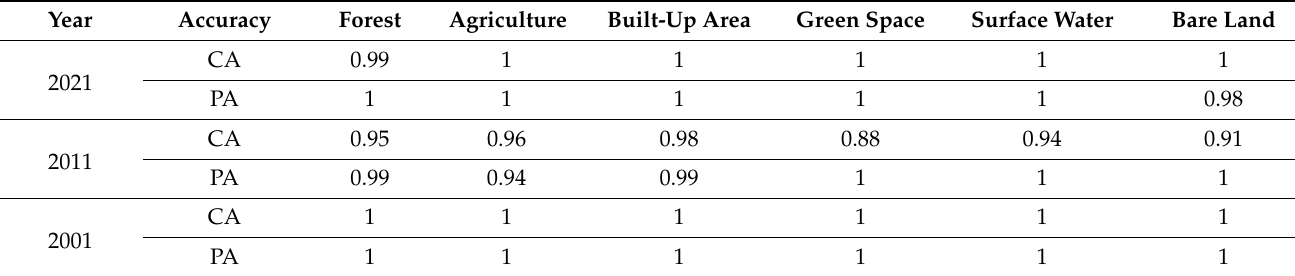
Table 7. Consumer and producer accuracy of the classification.